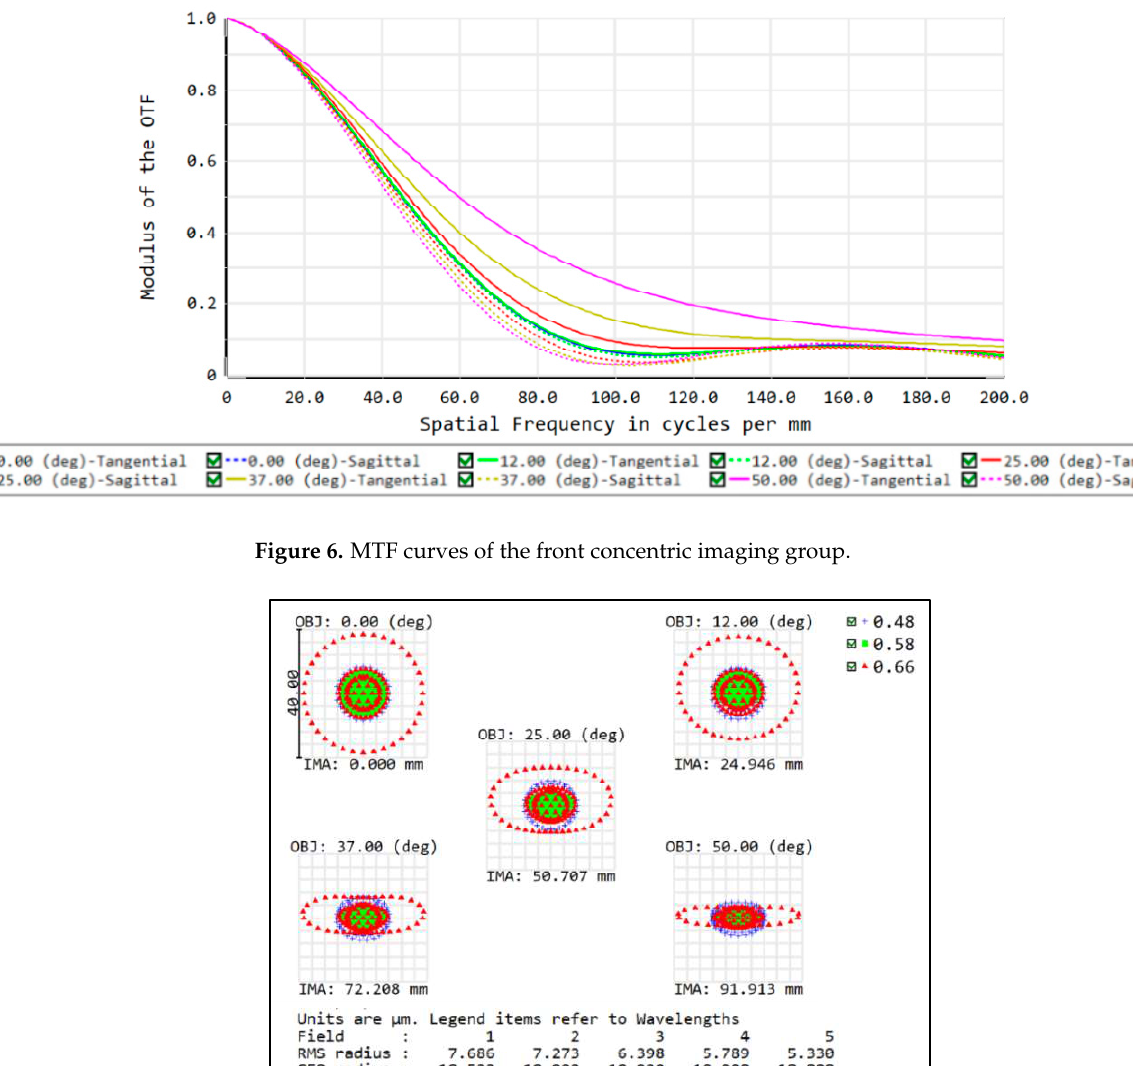
Figure 7. Spot diagram of the front concentric imaging group.